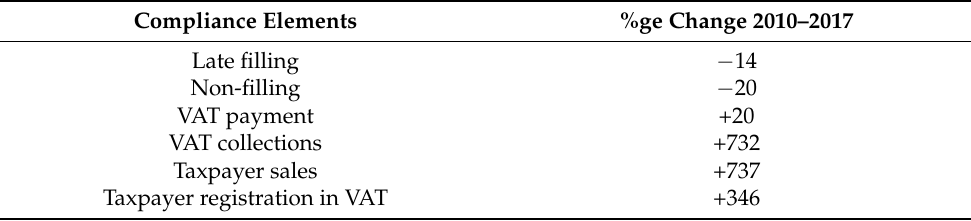
Table 1. Impact of EBM on VAT